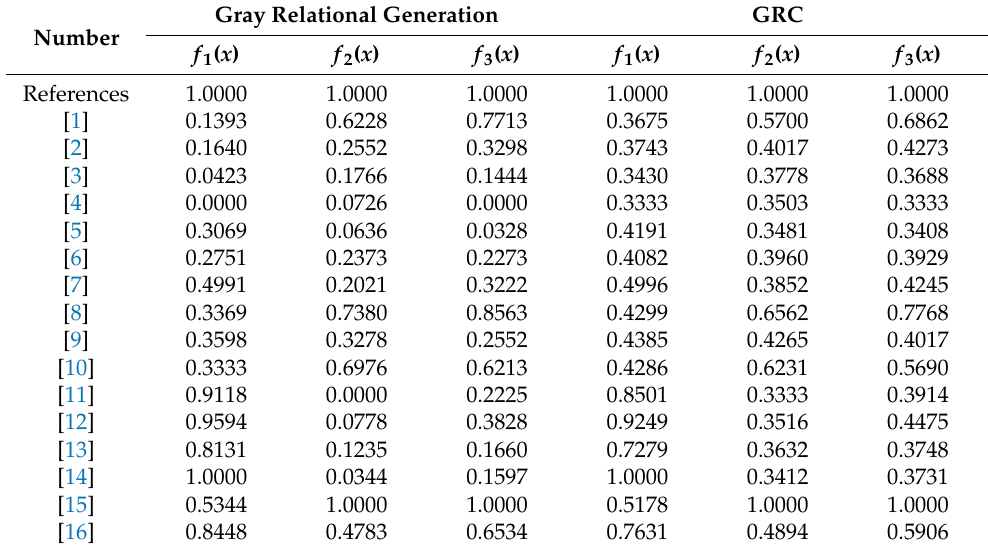
Table 6. The GRC of experimental